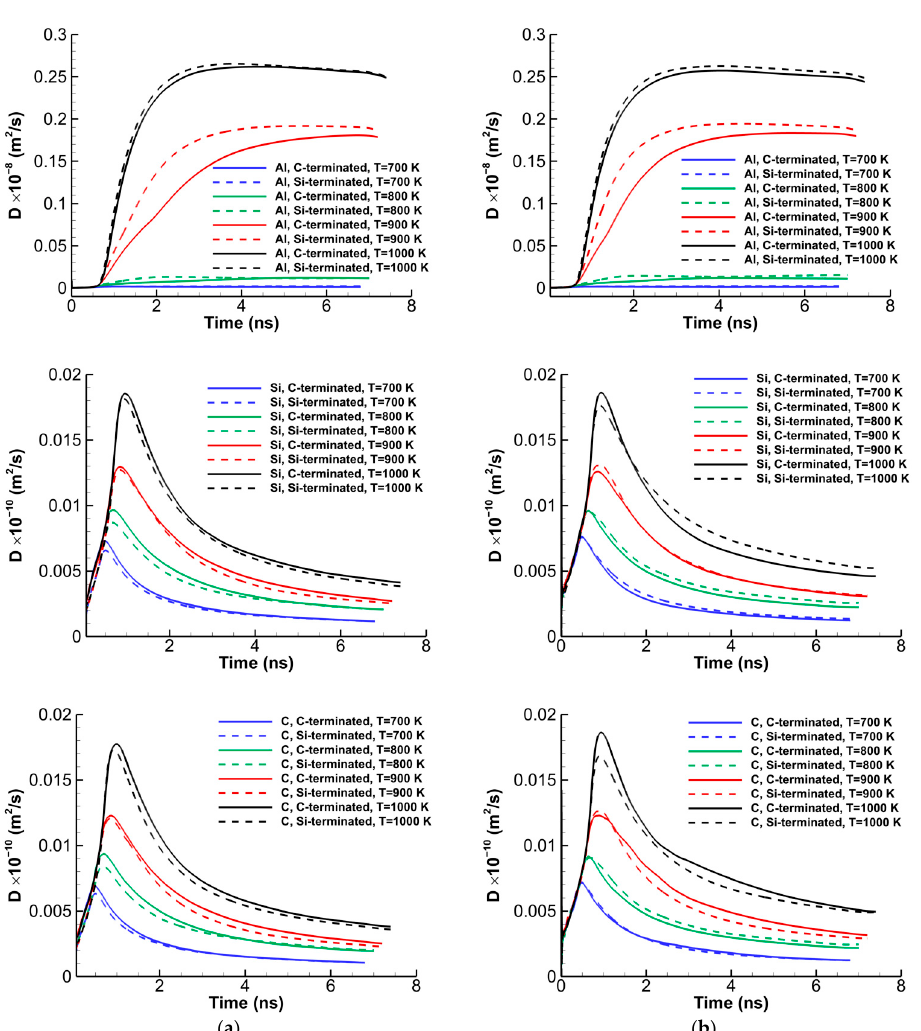
Figure 4. Time histories of the self-diffusion coefficients at different temperatures for different atoms of the ternary SiC/Al diffusion system with 20% vacancy in SiC in the C- and Si-terminated ( a ) 6H-SiC/Al and ( b ) 3C-SiC/Al interfaces.